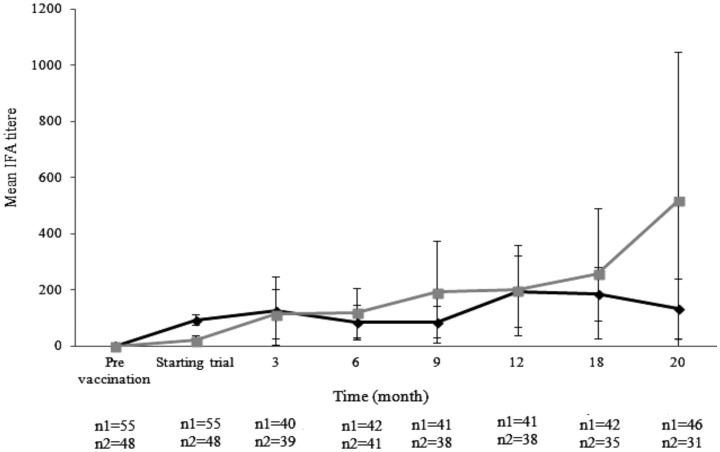
Mean levels of specific anti-Leishmania total IgG antibody in the sera of vaccinated (♦) and unvaccinated dogs (▪).The dogs in the vaccinated group were injected with the L. infantum H-line and then transferred into the endemic area over a period of 1.5 months. Antibodies were detected by IFA pre-vaccination and over a 20 month period follow-up. The number of vaccinated dogs (n1) and unvaccinated dogs (n2) were assayed at each individual time point. After 1.5 months transferred into the endemic area. Each point represents average ± SDM.